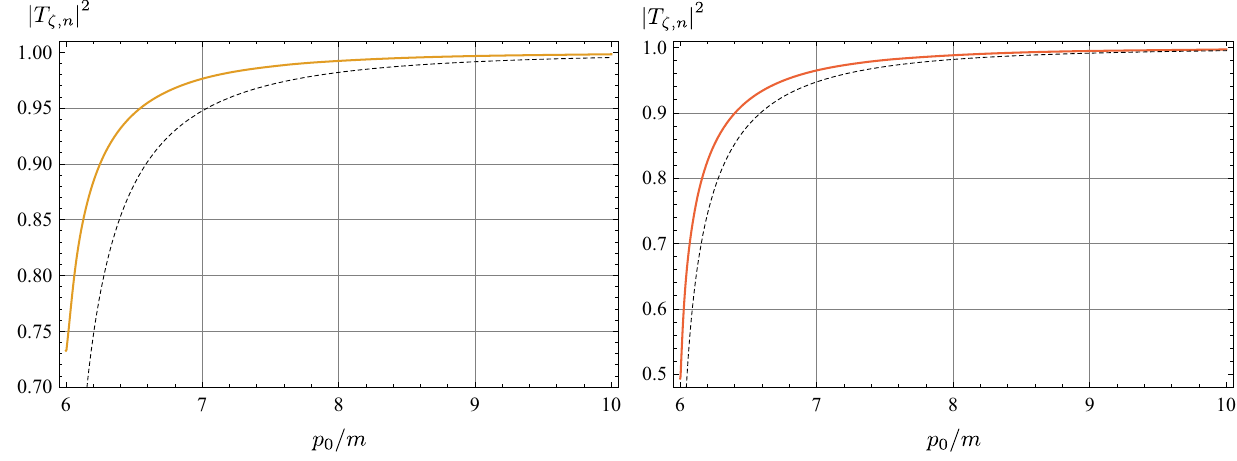
and m ξ 1 = m ξ 2 = 1 / 50 while in the right panel, E = 500 E c and m ξ 1 = m ξ 2 = 1 / 100. The lower bound of (cid:19) 1 is the same for both plots which, in this system of units, is p 0 / m = 6